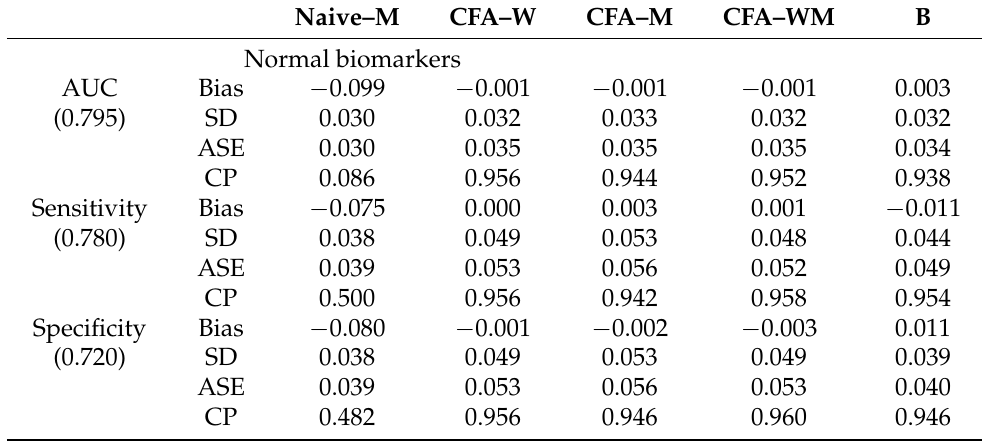
Table 3. Simulation when W i = X i + U 1 , M i = 0.2 + 0.8 X i + V i , in which σ u = 1 and σ v =